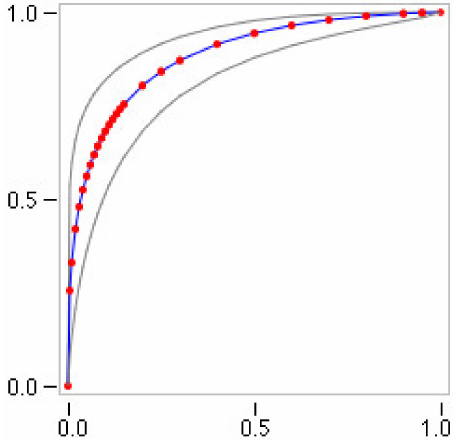
Figure 8. The ROC area of all the final adjusted validation data: AUC